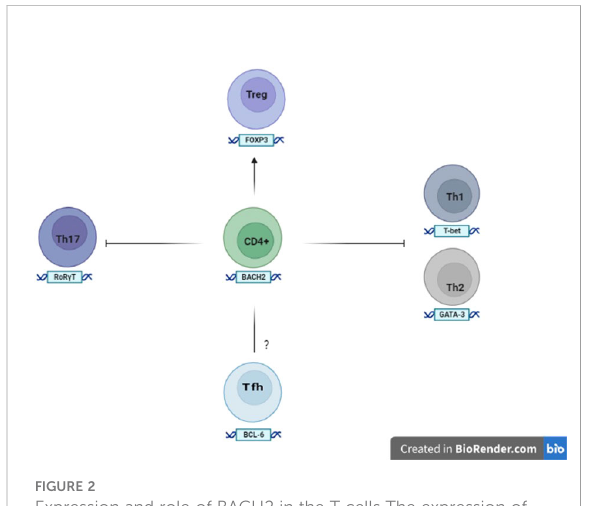
FIGURE 2 Expression and role of BACH2 in the T cells The expression of BACH2 promotes the differentiation of Tregs, while at the same time suppresses the factors involved in the formation of the Th1, Th2 and Th17 subsets. The role of BACH2 in the development and differentiation of Tfh (follicular T helper lymphocytes) remains to be